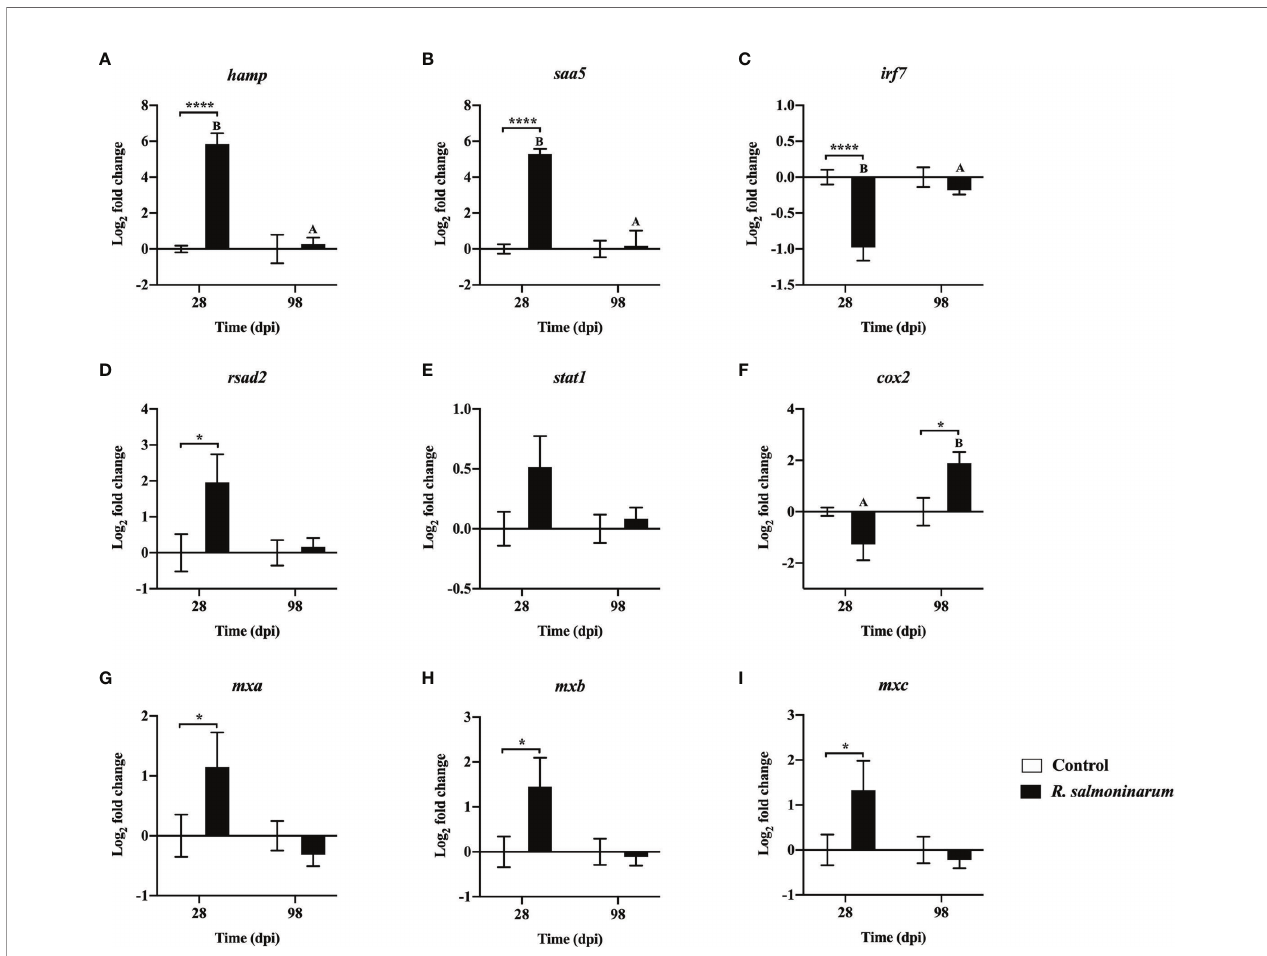
FIGURE 5 | Expression of transcripts related to regulation of the innate (A – E) and in fl ammatory (F – I) immune response in lump fi sh head kidney in response to R. salmoninarum infection at 28 and 98 days post infection (dpi). Transcript expression levels in head kidney from control (PBS-mock infected group) and infected [high dose (1×10 9 cells/dose) of R. salmoninarum ] lump fi sh at 28 and 98 dpi were analyzed using qPCR. Relative expression was calculated using the 2 − DD Ct method and log2 transformed; etif3d and pabpc1b were the endogenous control genes. A two-way ANOVA test, followed by the Sidak multiple comparisons post hoc test was used to identify signi fi cant differences between treatments (control and infected groups) at a single time point, and for a given treatment at different time points (28 and 98 dpi). Asterisks (*) represent signi fi cant differences between treatments at each time-point (* p < 0.05, **** p < 0.0001). Different letters represent signi fi cant differences between control (lower case) and infected (upper case) groups at 28 compared to 98 dpi. Each value is the mean ± S.E.M ( n =